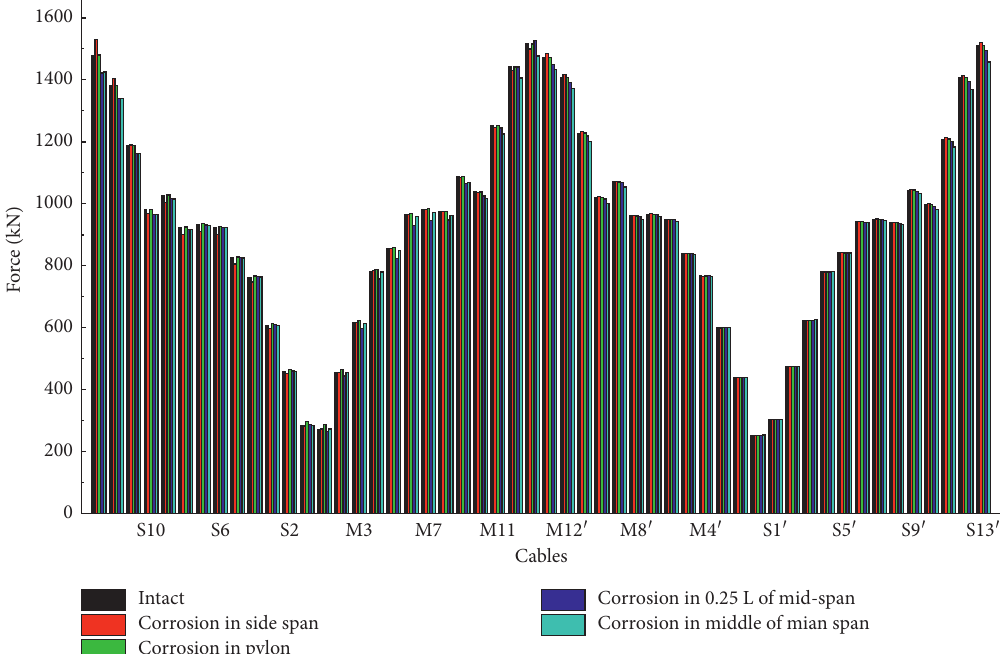
Figure 15: The cable forces in the corroded truss girder